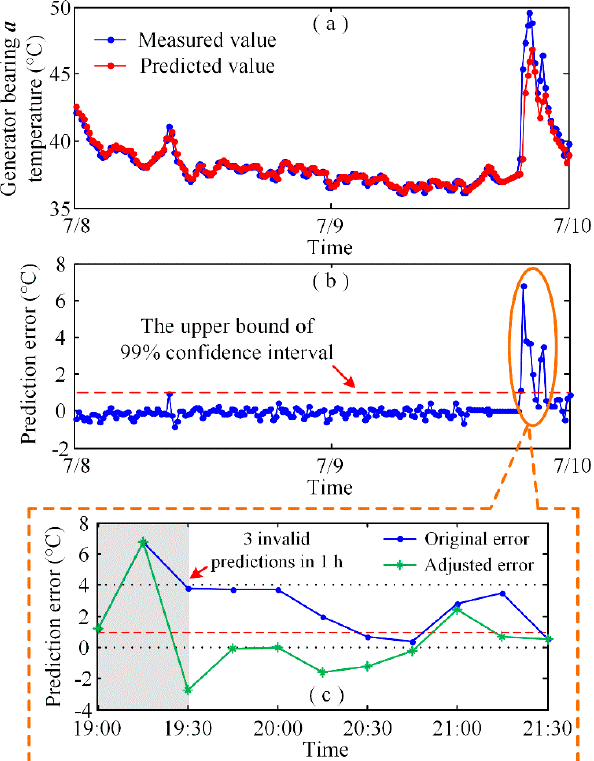
Figure 13. Prediction results of generator bearing a temperature: ( a ) Measurement and prediction results; ( b ) Prediction error series; and ( c ) Error series for the adjusted predictions. Table 5. WT outage cases and corresponding MAE for the original predictions and the adjusted predictions.